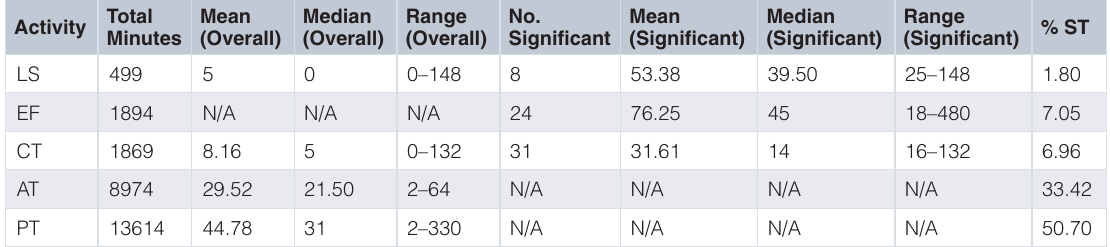
Table 5. Breakdown of ST usage. Just over 50% of all available sessional time was used for operating during the audit